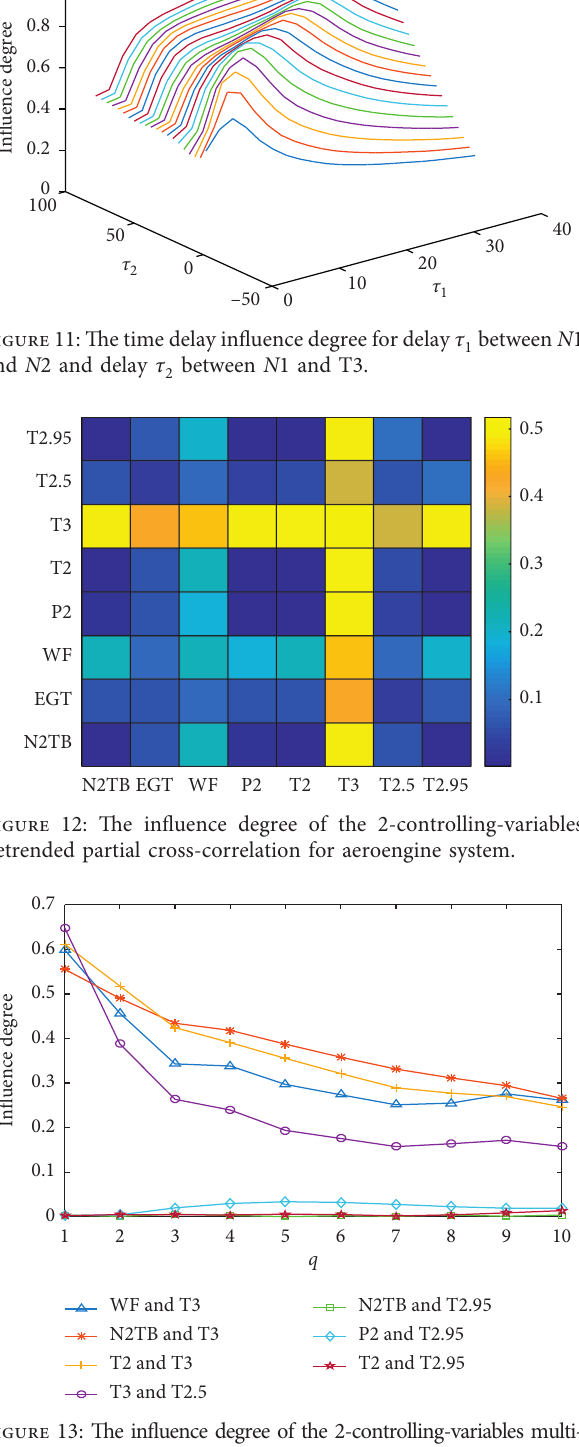
Figure 13: The influence degree of the 2-controlling-variables multi- fractal detrended partial cross-correlation for the aeroengine system.